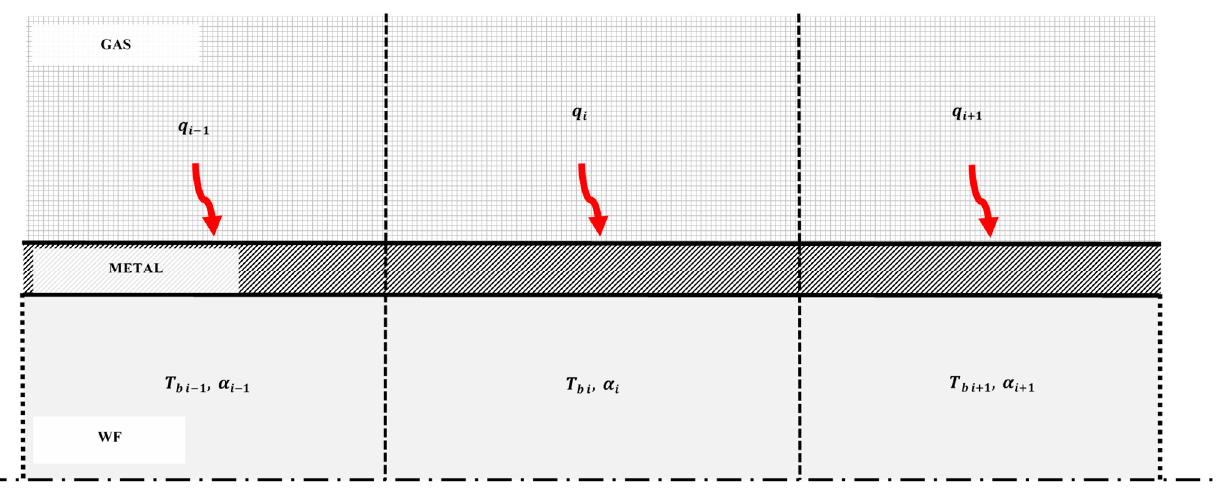
Figure 4. Layout and schematic paradigm of the discretized model proposed, where red arrows represent the heat flux.